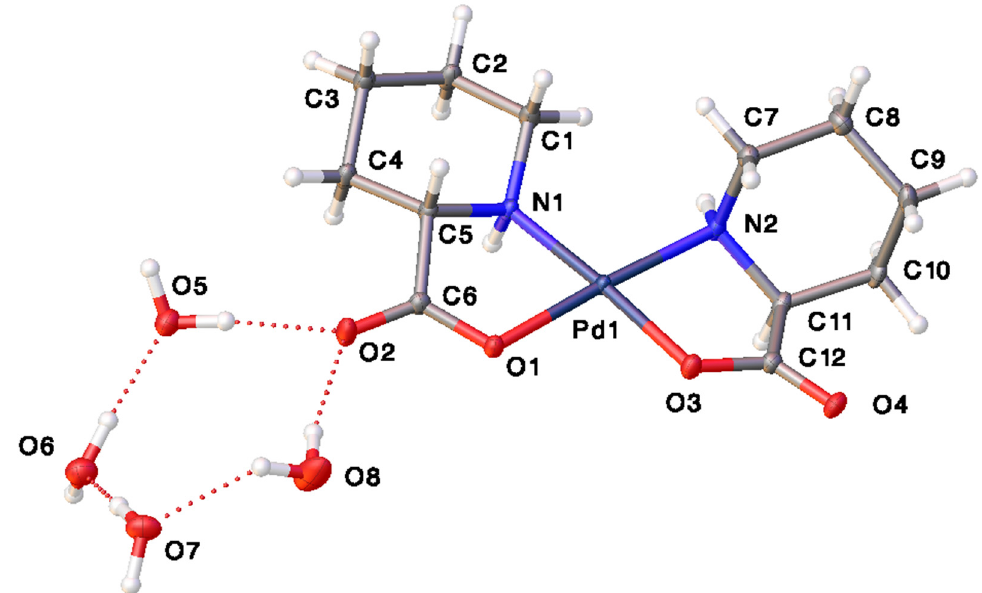
Figure 11. ORTEP plot of cis -bis-(L-pipecolinato)palladium(II), ( 7 ). Thermal ellipsoids are shown at the 50% probability level. CCDC:1913623.